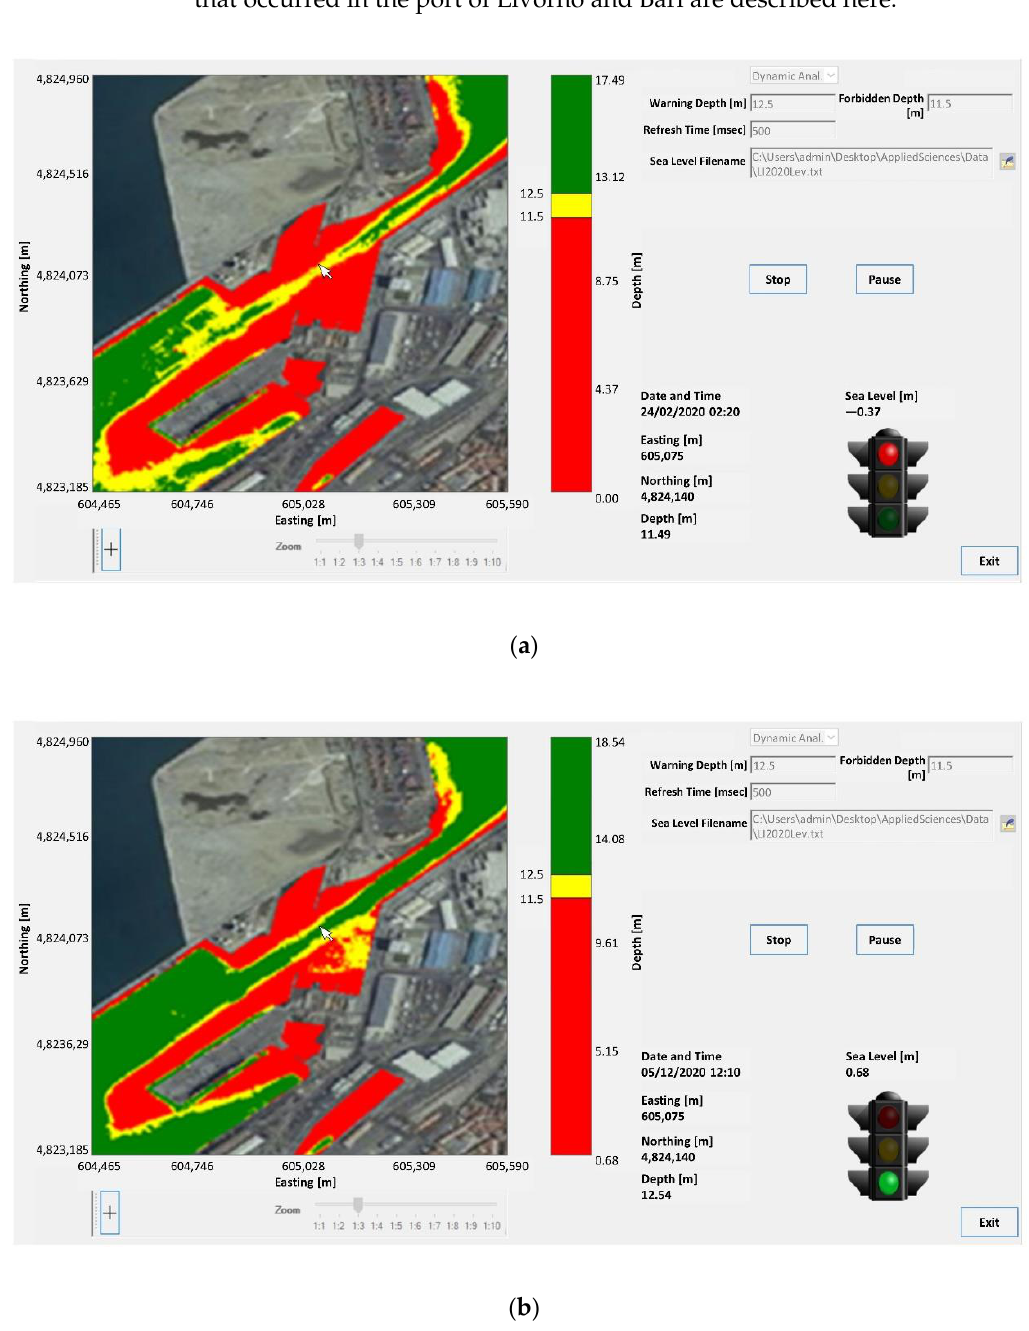
Figure 14. Detail of virtual traffic lights in the port of Livorno: ( a ) on 24 February 2020 at 02:20; ( b ) on 5 December 2020 at 12:10; thresholds equal to 11.5 and 12.5 m.